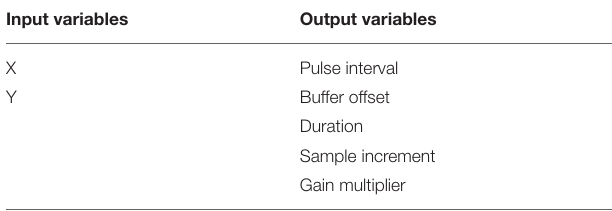
TABLE 5 | Input and output variables for parametric control of granular synthesis example.